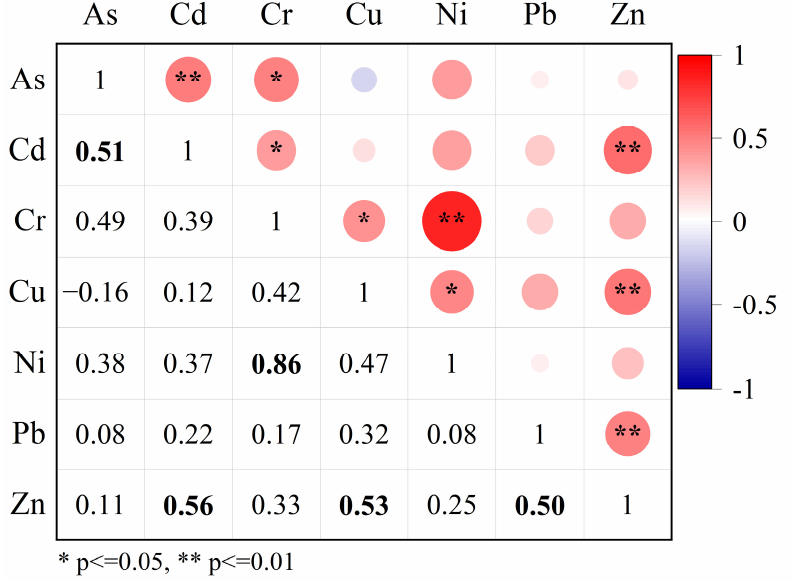
Figure 3. Pearson correlation analysis of heavy metals in soils. The correlation coefficients ( p < 0.01) are remarked in bold. Table 3. Rotated component matrix for soil heavy ‐ metals.